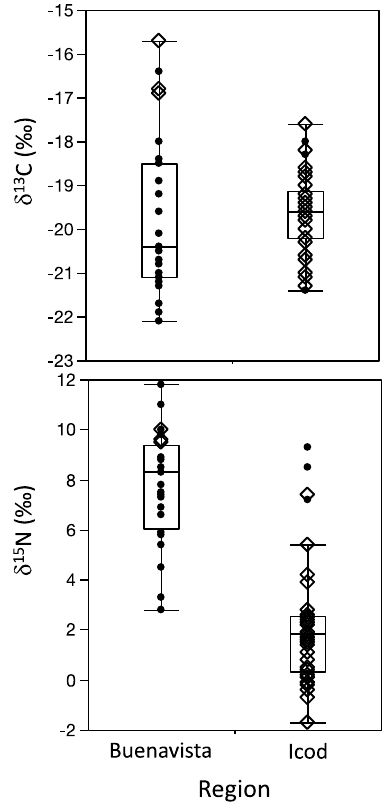
Figure 4. Boxplots comparing δ 13 C and δ 15 N values for taxa from Icod and Buenavista del Norte. Boxes represent 25 and 75 ‰ quartiles, and whiskers contain 1.5 times the interquartile range. Diamonds demarcate Canariomys bravoi at each site.